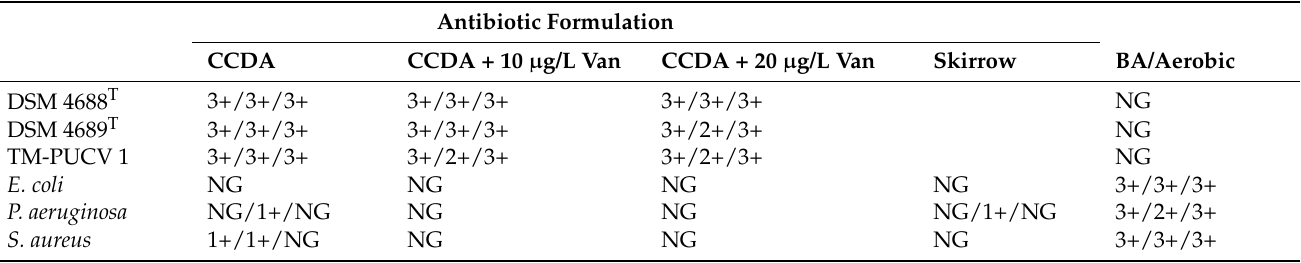
Table 4. Qualitative growth of strains C. jejuni (ATCC 33560 T ), C. coli (DSM 4689 T ), S. aureus ATCC 25923, E. coli ATCC 25922, and P. aeruginosa ATCC 27853 on CAMPYAIR incubated under aerobic conditions and supplemented with different antibiotic